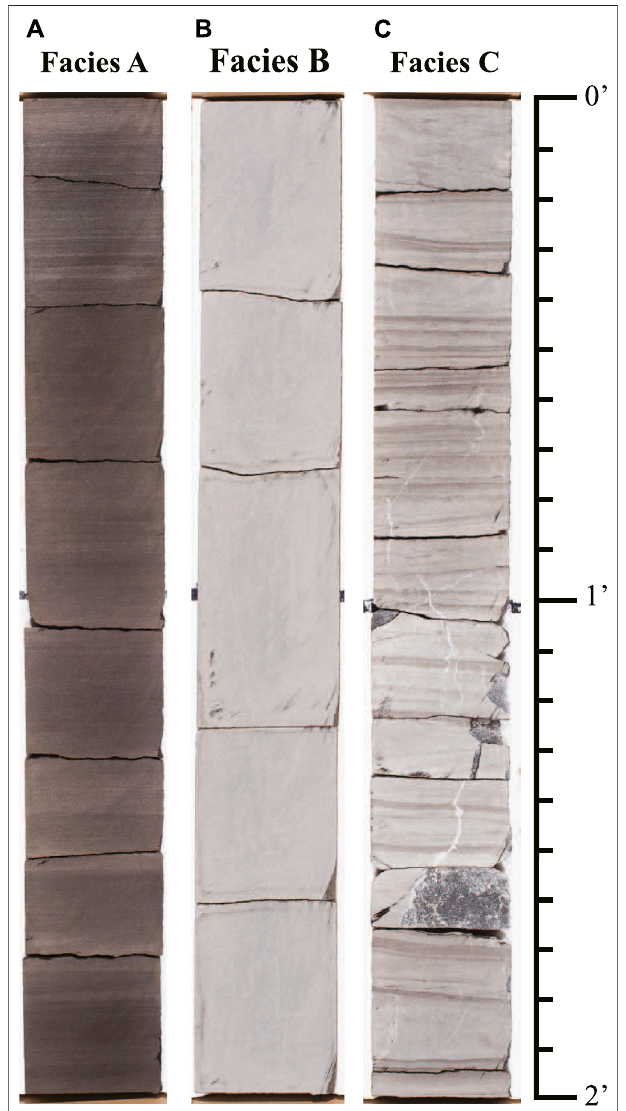
FIGURE 2 | Facies. (A) A : mudstone to siltstone with scattered sedimentary features such as lamination, burrowing and bioturbations, (B) B : massive bedded packstone to grainstone, and (C) C : hummocky cross- strati fi ed-planarlaminatedpackstonetograinstone.TransitionsFrom (A) to (C) , facies represent a change from distal to proximal shelf depositional